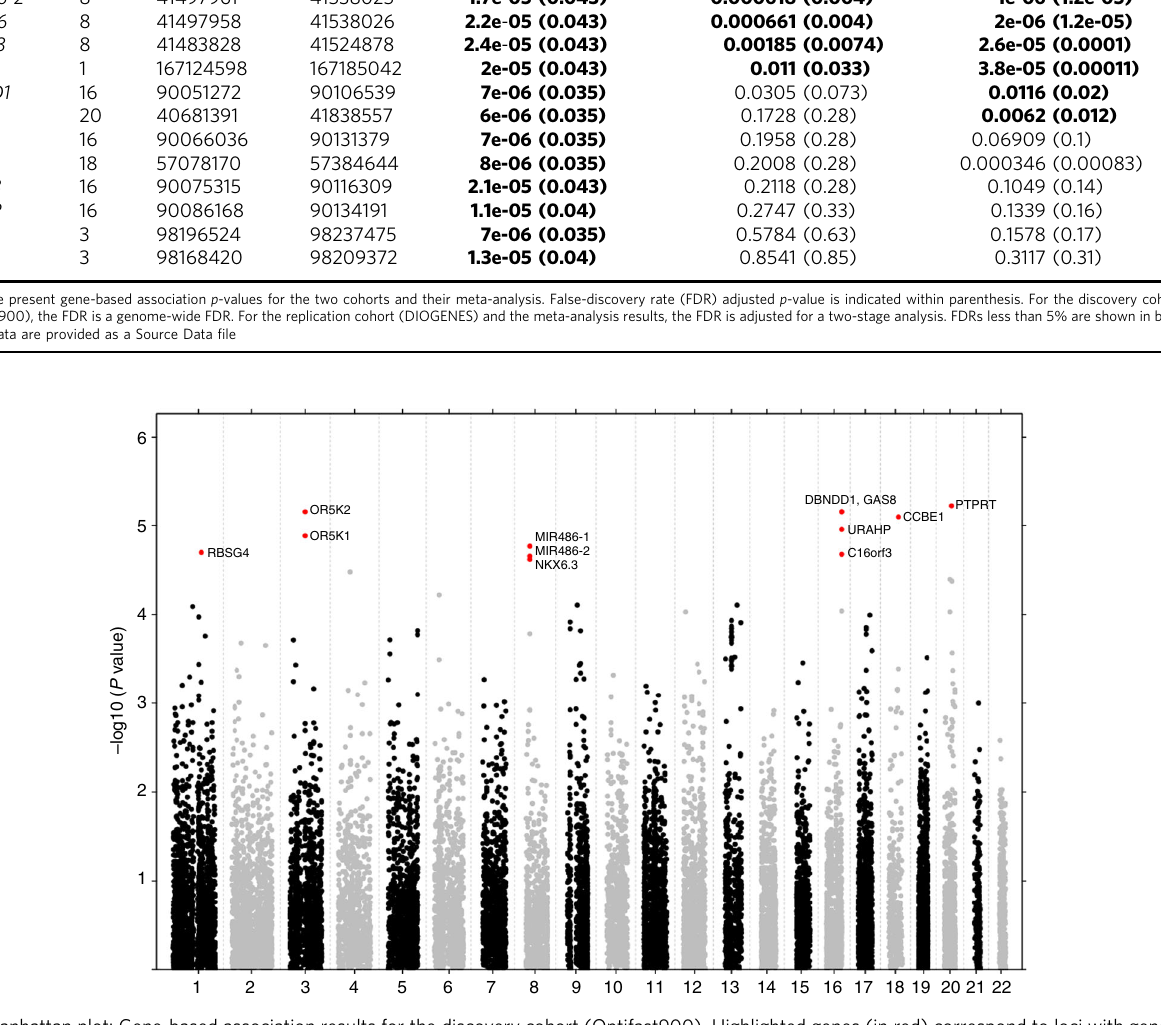
Fig. 1 Manhattan plot: Gene-based association results for the discovery cohort (Optifast900), Highlighted genes (in red) correspond to loci with genome- wide signi fi cant association signals (FDR < 5%). Source data are provided as a Source Data fi le